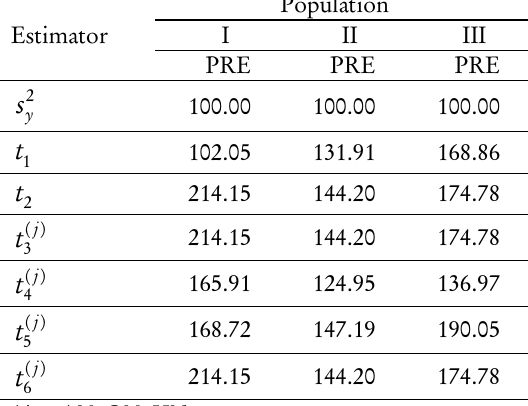
The PREs of different estimators